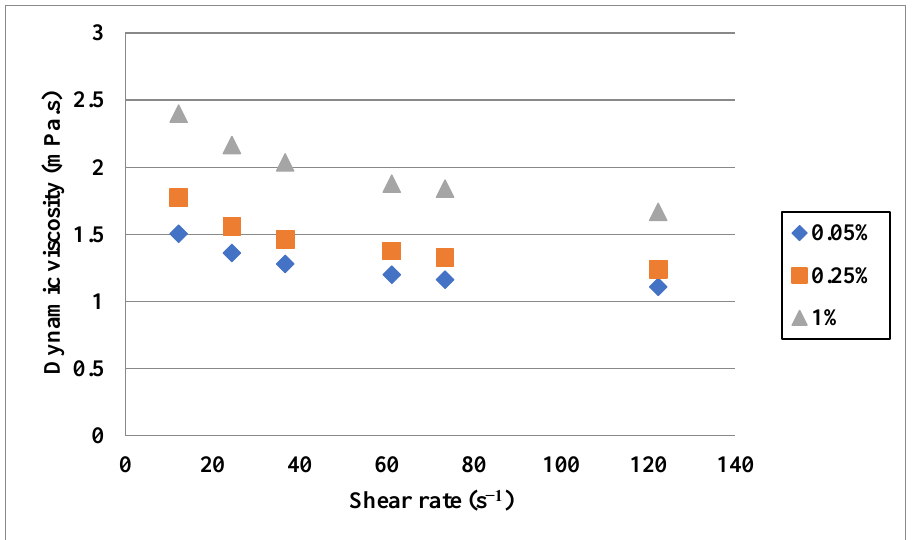
Figure 9. Effect of shear rate on the DV of graphene-SiO 2 /water at a temperature of 25 °C. Adapted from Ref. [90].